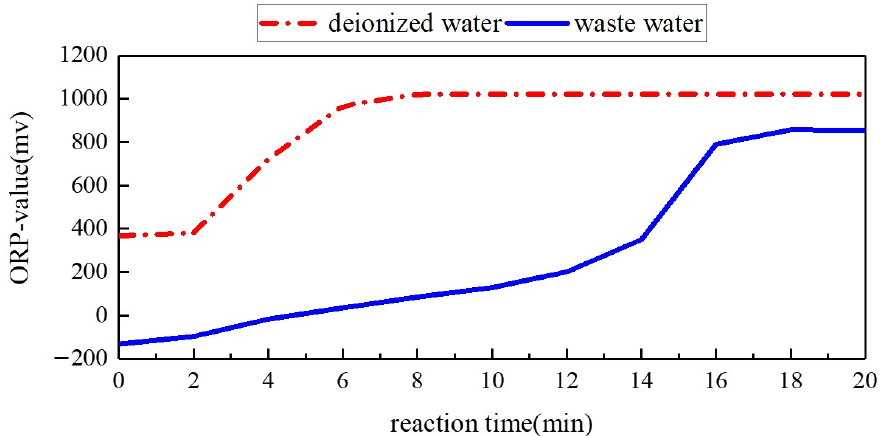
Figure 3. ORP curve under the combined action of ozone (25 g · m − 3 ) and manganese dioxide as catalysts (6 g · L − 1 ).